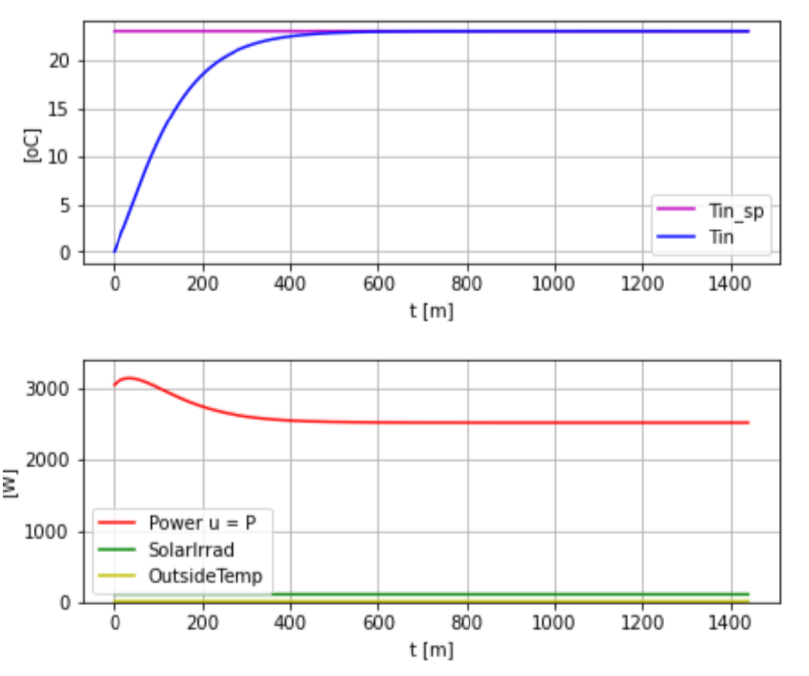
Figure 10. Tuned PI control output .